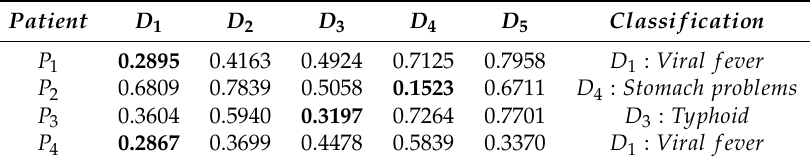
Table 12. The results generated by proposed method in Example 5.